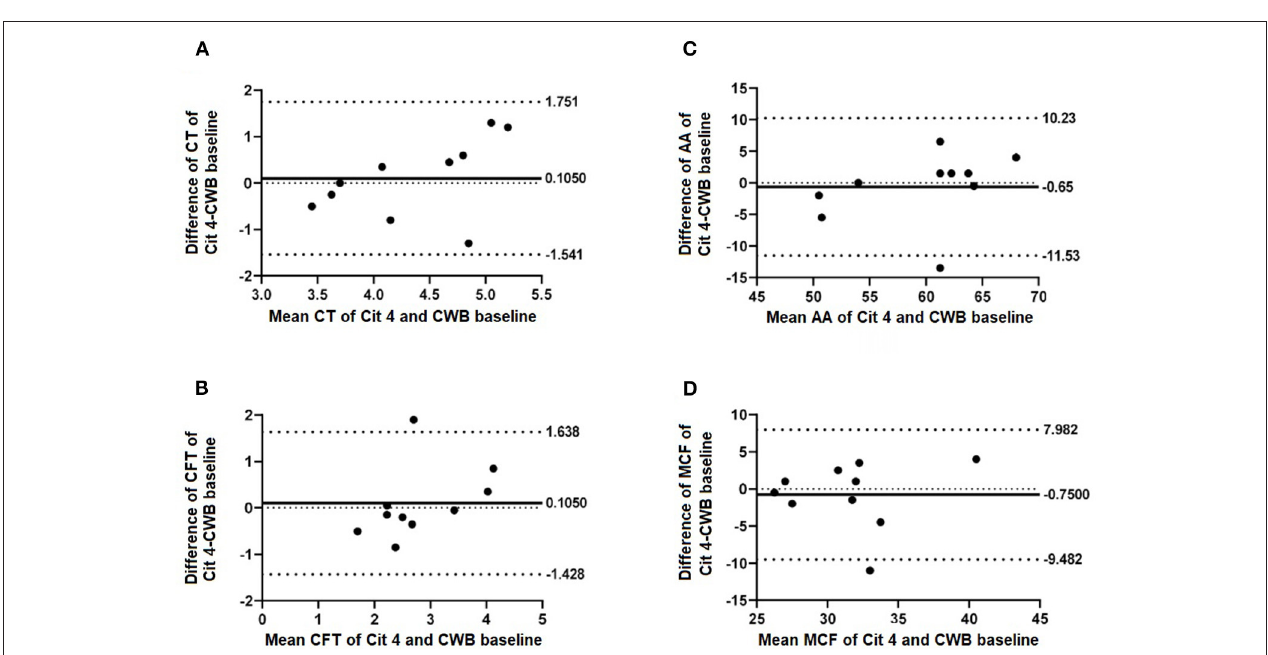
FIGURE 2 | Selected Bland-Altman plots indicating biases of measured parameters of CWB baseline compared with 4h rested CWB samples (Cit 4). Mean difference (bias) is indicated by solid lines with dashed lines indicating 95% agreement interval of + / − standard deviations. Parameters included are (A) CT, (B) CFT, (C) AA, and (D)